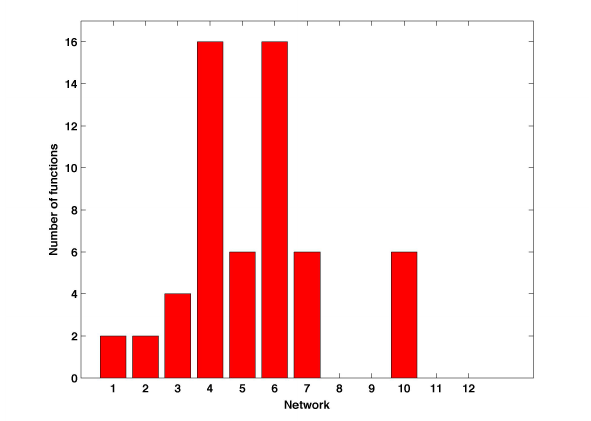
Fig. 15. Number of function templates that have have both non-canonical steady states and non-canonical cycles in a 5- cell non-quotient